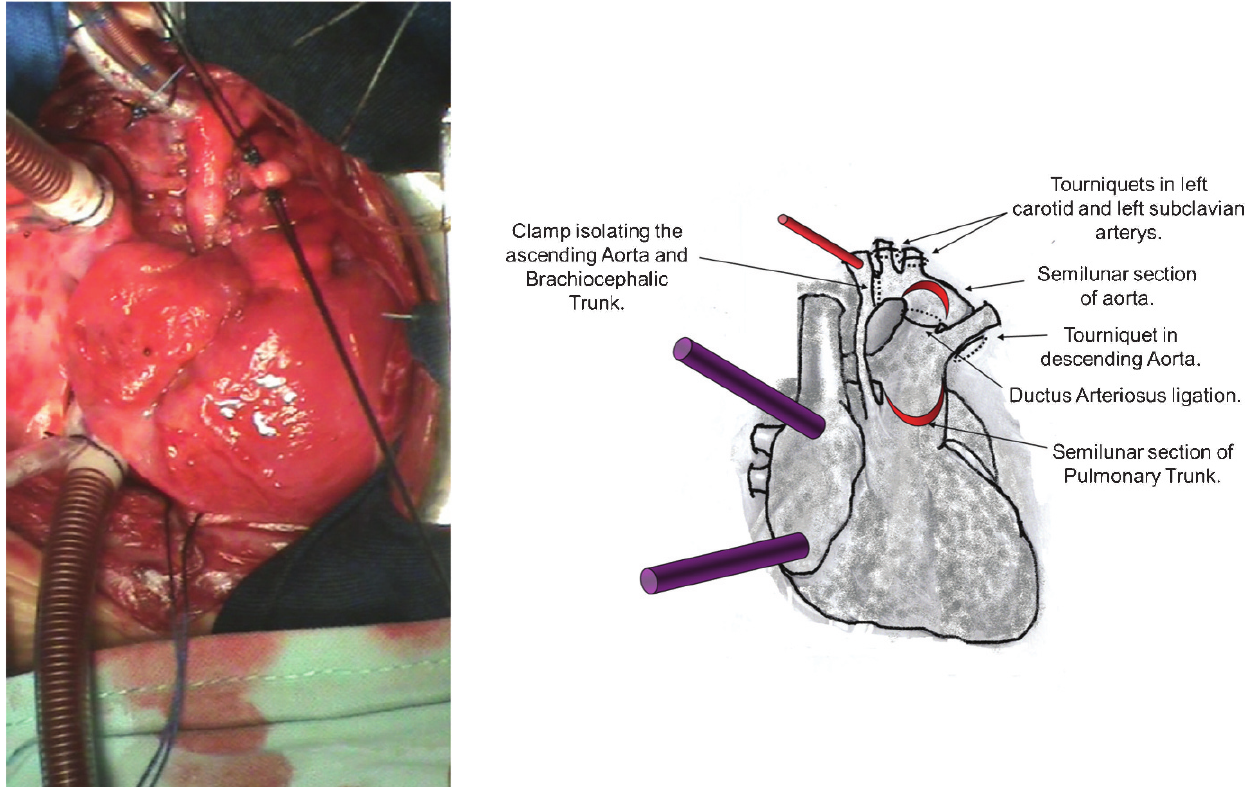
Figure 1 - Photograph and diagrammatic schema of the cannulation of the brachiocephalic trunk and double venae cavae for extracorporeal circulation (ECC). A tourniquet was placed in the left carotid, the left subclavian artery and the descending aorta. ECC was initiated, and the DA was ligated. A clamp was placed at the aortic arch, isolating the ascending aorta and the brachiocephalic trunk from the systemic circulation. The tourniquets were then closed. A flap was created in the semilunar section in the initial portion of the anterior pulmonary trunk 3 cm above the pulmonary valve. A second semilunar incision was made in the anterosuperior side of the arch of the aorta near the left carotid and left subclavian arteries, creating the